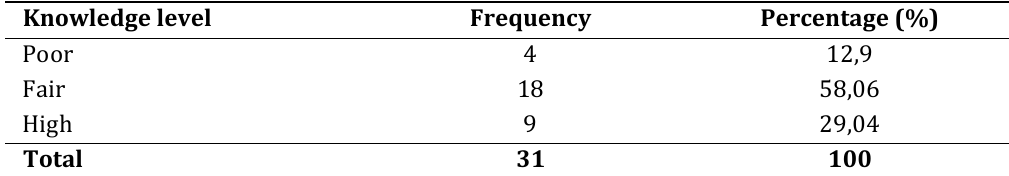
Frequency Distribution of Respondents' Knowledge Level After Intervention (n=31)